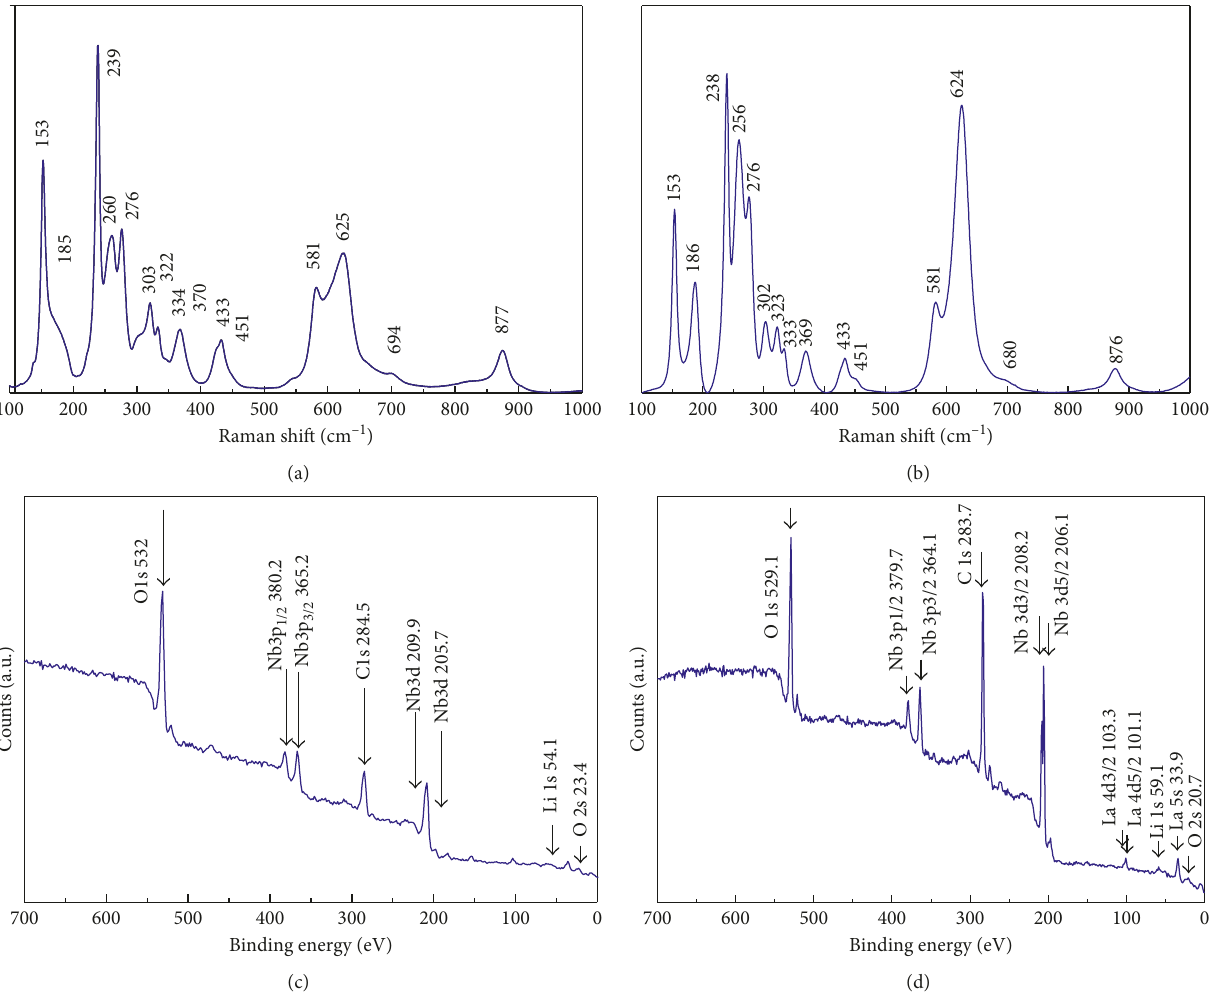
Figure 4: Raman spectrum of multiferroic: (a) LiNbO (d) La 0.05 Li 0.85 NbO 3